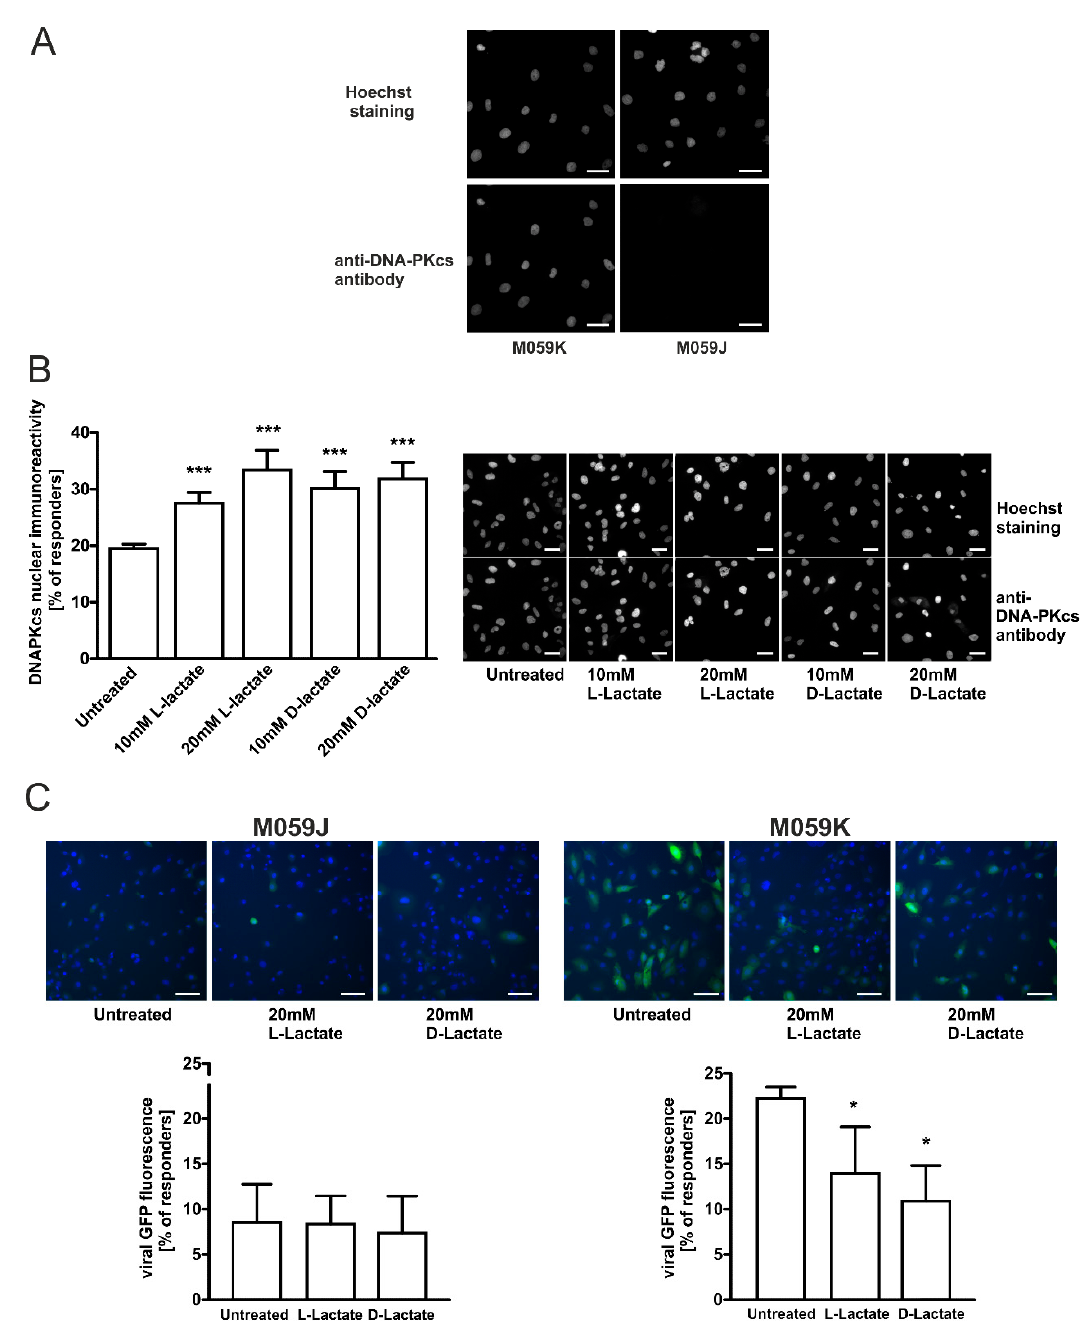
Figure 3. DNA-PKcs-proficient glioma M059K cells are prone to lactate-driven modulation of DNA-PKcs and lentivirus transduction efficacy but not the DNA-PKcs-deficient counterpart-M059J. ( A ) Immunocytochemical staining of DNA-PKcs in M059K and M059J cells, representative images are shown. ( B ) M059K cells were treated with increasing concentrations of L-lactate and D-lactate for 24 h before measuring cellular DNA-PKcs immunoreactivity. The graphs display the percentage of high DNA-PKcsimmunoreactive M059K cells (responders) whose fluorescence overcame the threshold of mean fluorescence set on untreated cells.Data are presented as mean ± SD (n = 3). Scale bar is 50 µm ( C ) M059K and M059J cells were incubated in the presence or absence of 20 mM L- or D-lactate for 24 h, followed by infection with copGFP Control Lentiviral Particles at MOI = 5 for 24 h before changing the medium. After 48 h, the infected cells were stained with Hoechst 33,342 and immediately analyzed using an ArrayScan VTI HCS Reader. The graphs show the percentage of high copGFP expressing M059K and M059J cells (responders) whose fluorescence overcame the threshold of mean fluorescence set on untreated M059K cells. Data are presented as mean ± SD (n = 3). Images showed representative microscopic areas for the particular treatment from the same experiment. * p < 0.05, and *** p < 0.001. The scale bar is 100 µm.